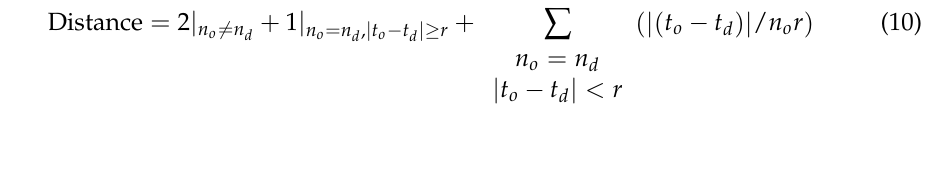
Figure 10. The spike sequence learning with different learning algorithms. ( a1 – c1 ): The training process, the output spikes after the 300th training epoch, the calculated distance after each training epoch with ReSuMe method. ( a2 – c2 ): with delay combined ReSuMe method. P_t=0.032, ω _0=0.6, P_th=0.006,w_f=0.001. The actual output could never reach the desired one because the weight does not contribute to the spiking time of the MRR ‐ based neuron, as illustrated in Figure 3(c1–c3). It seems that such neuron does not fit for temporal encoding in a SNN, but it could be useful for rate coding that encodes input energy into multiple spikes as demonstrated in Figure 3(a3, b3), which deserves further investigation in future works. However, we ad ‐ dress this issue via introducing delay learning in the traditional weight ‐ based ReSuMe